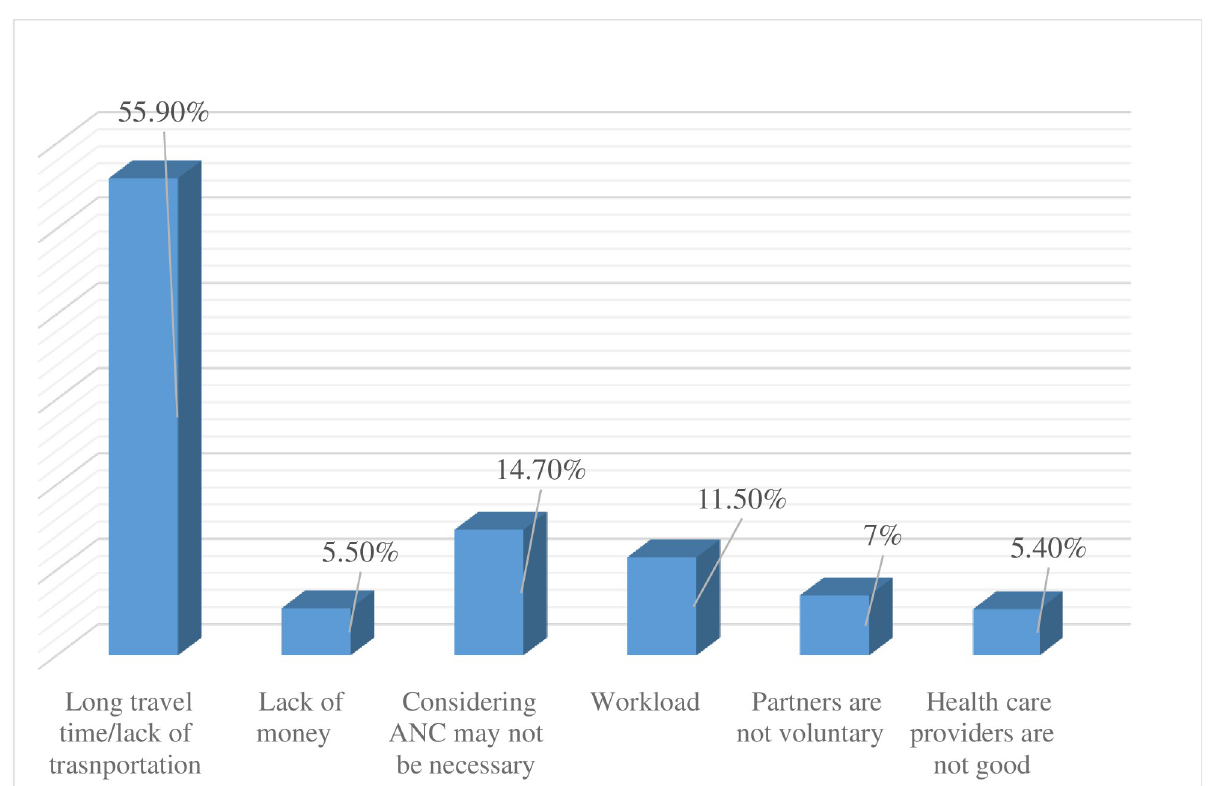
Fig 1. Barriers to use antenatal care and institutional delivery among home-delivered women in rural Sehala Seyemit district, northern Ethiopia, 2020.